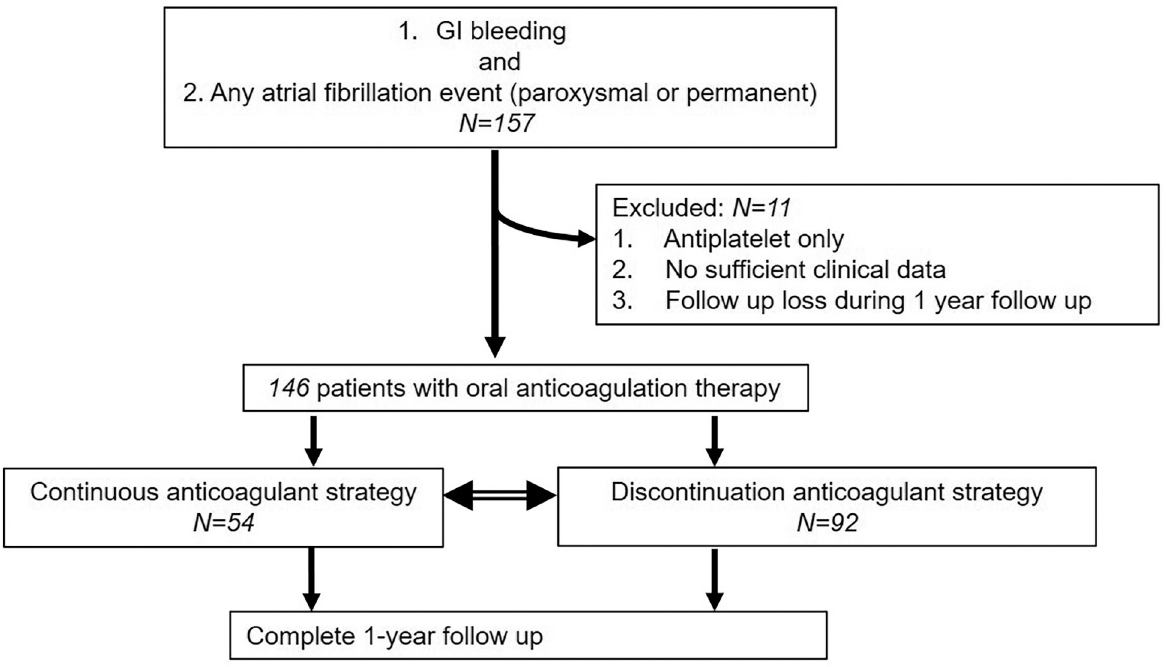
Fig 1. Flowchart of patient